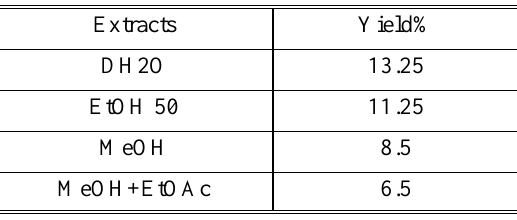
Table 1.Extraction yield